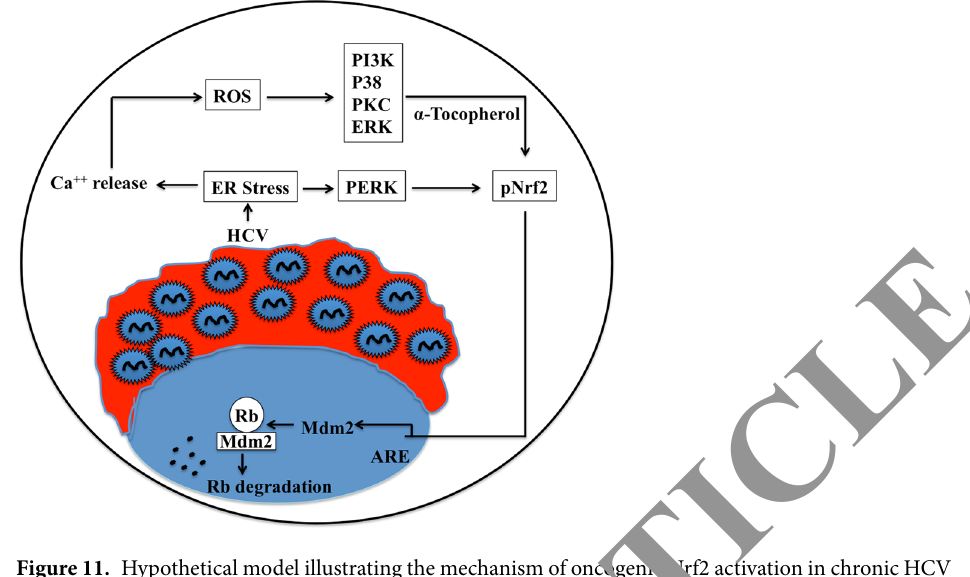
Figure 11. Hypothetical model illustrating the mechanism of oncogenic Nrf2 activation in chronic HCV infection due to